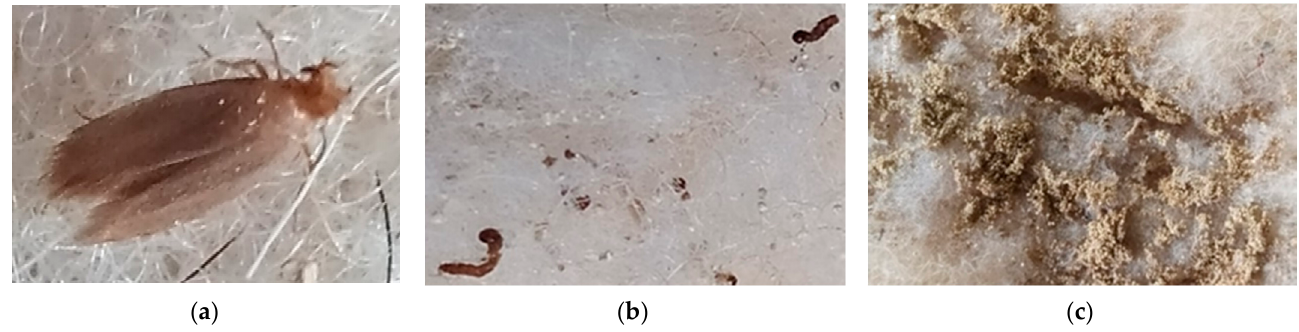
Figure 5. Exposure of heat-insulating mattresses specimens to assess biological resistance to attack by worms and insects: ( a ) in the presence of adult insects; ( b ) in the presence of larvae; ( c ) in the presence of insect eggs.